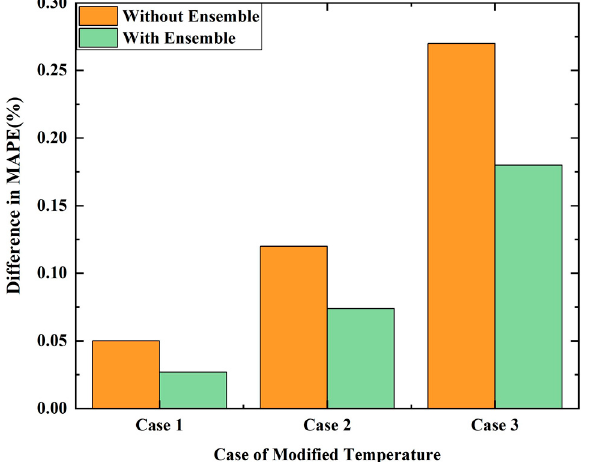
Figure 10. Comparison of the proposed model with ensemble thinking and the proposed model without ensemble thinking in different temperature modification cases: case 1, mean 0 °F and stand- ard deviation 1 °F; case 2: mean 0 °F and standard deviation 2 °F; case 3, mean 0 °F and standard deviation 3 °F; MAPE, mean absolute percentage error. Table 5. Comparison of computation time concerning the proposed model with ensemble thinking and the proposed model without ensemble thinking.